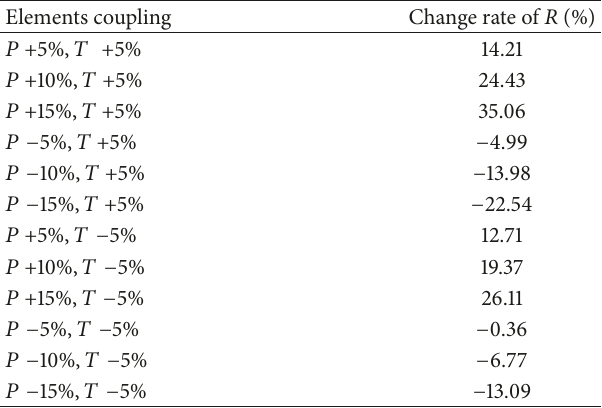
Table 10: Results of 𝑅 changes with the elements coupling